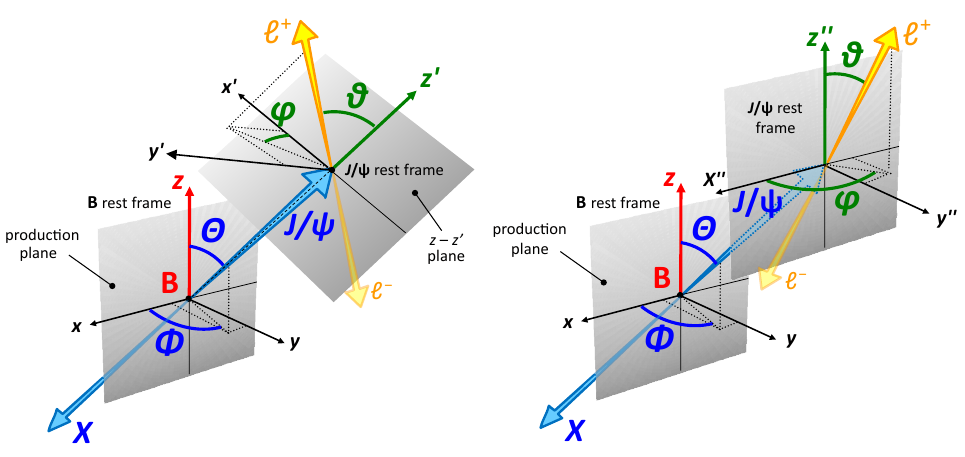
Figure 1 . Two alternative definitions of the angles used in the description of the cascade decay B → J /ψ X , J /ψ → ‘ + ‘ − . The Θ and Φ angles are always measured in the B polarization frame ( x, y, z ), for example the HX frame, while the (positive) lepton emission angles in the J /ψ rest frame, ϑ and ϕ , are either defined with respect to the ( x 0 , y 0 , z 0 ) cascade helicity (cHX) system of axes, as shown in the left diagram, or with respect to a system of axes geometrically identical to x, y, z , the cloned cascade frame (CC), as shown in the right